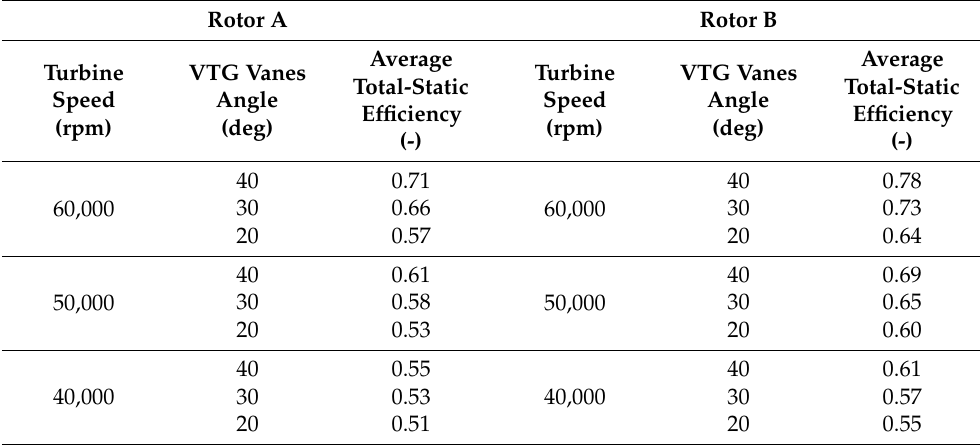
Table 14. The average total-static efficiency values of the first-stage rotor for two different rotor